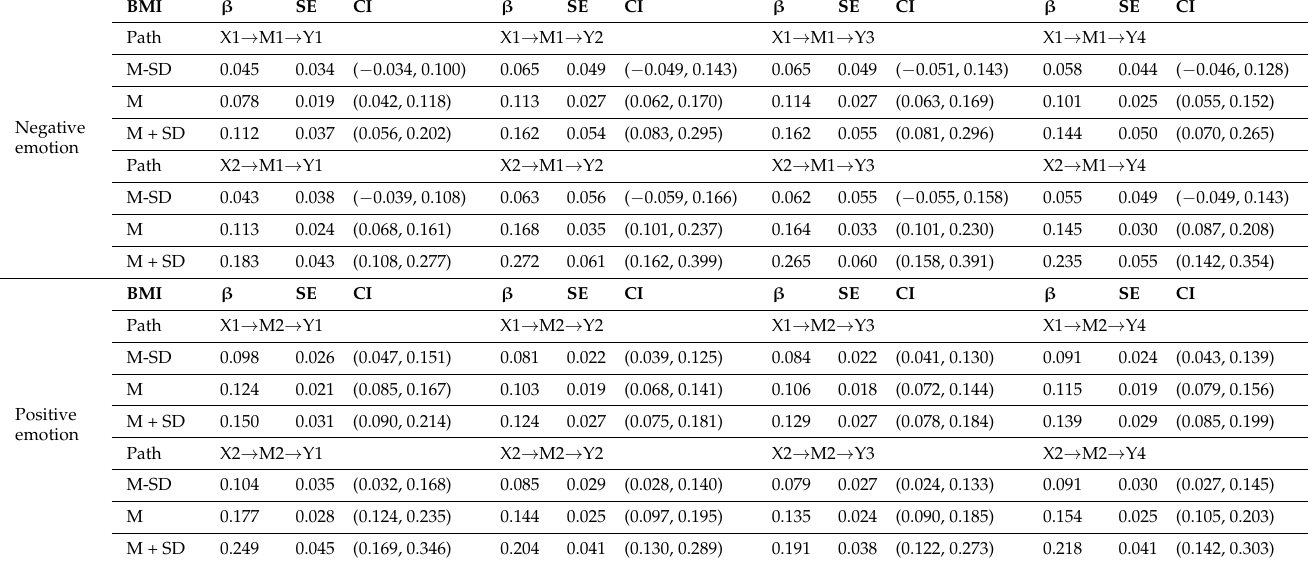
Table A4. The mediating effect of emotion at different levels of body mass index (BMI).